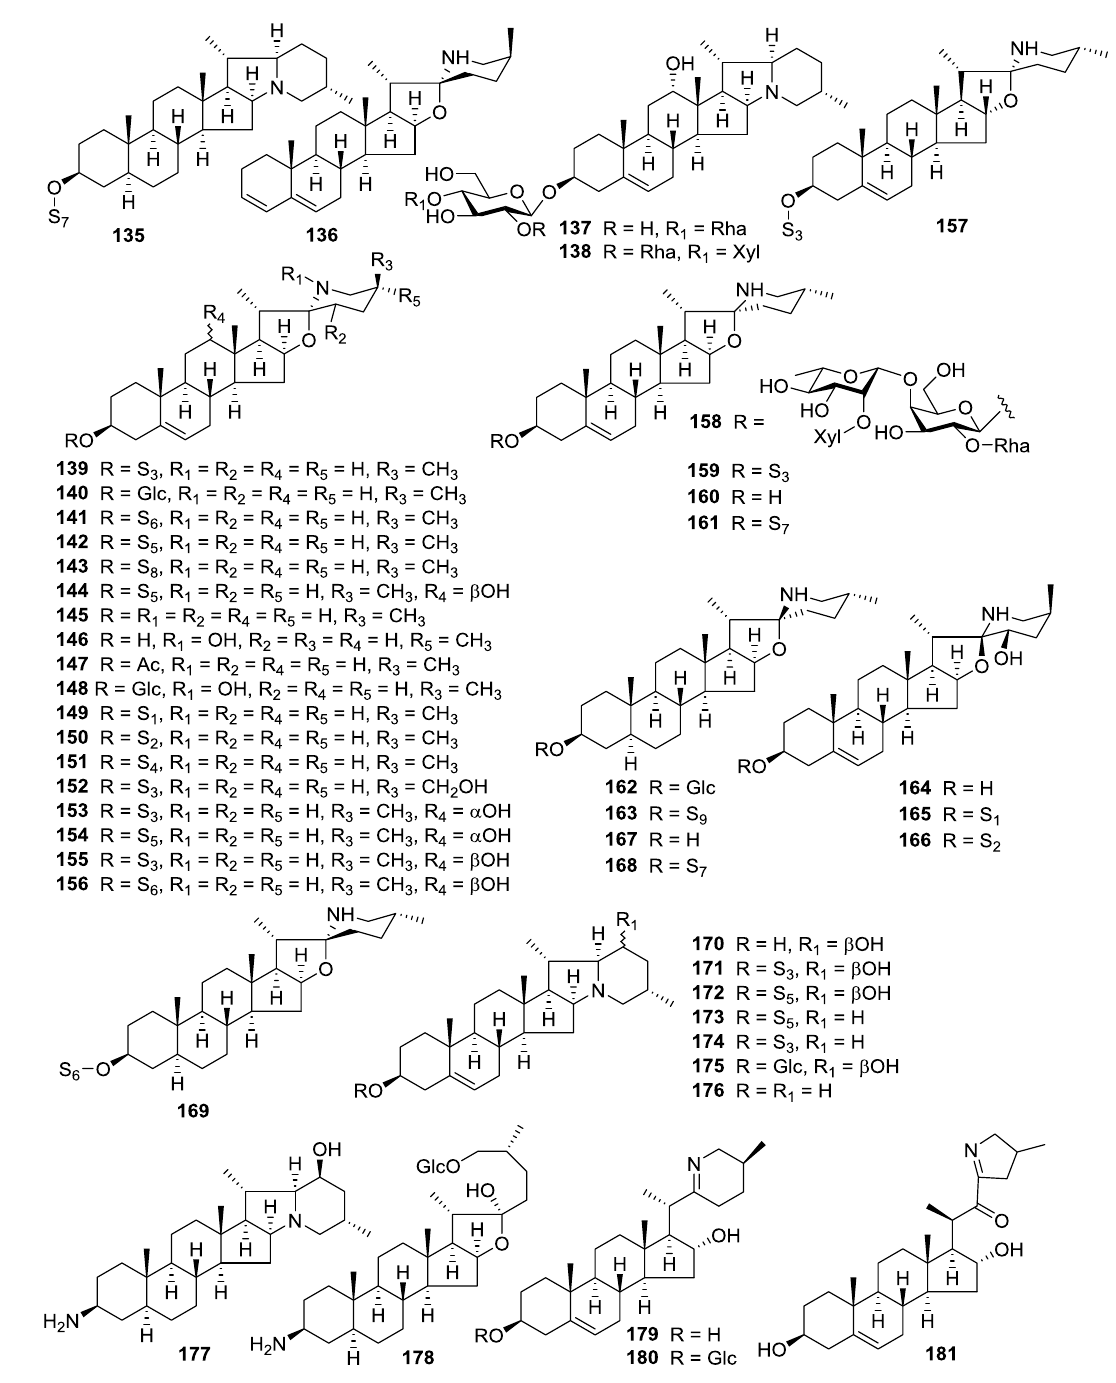
Fig. 2 Steroidal alkaloids 135 – 197 from